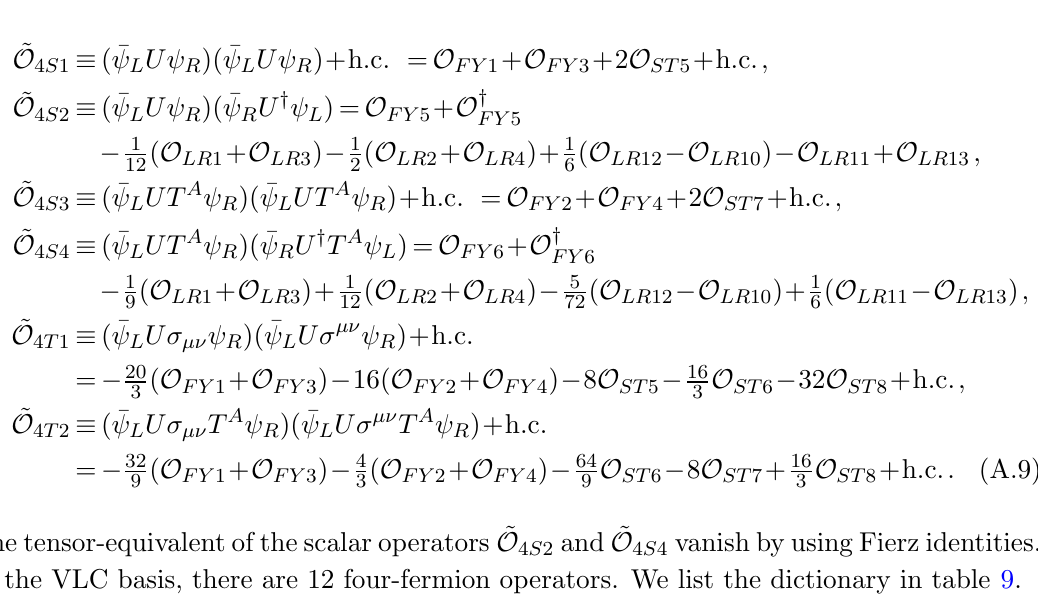
Table 9 . Dictionary of four fermion